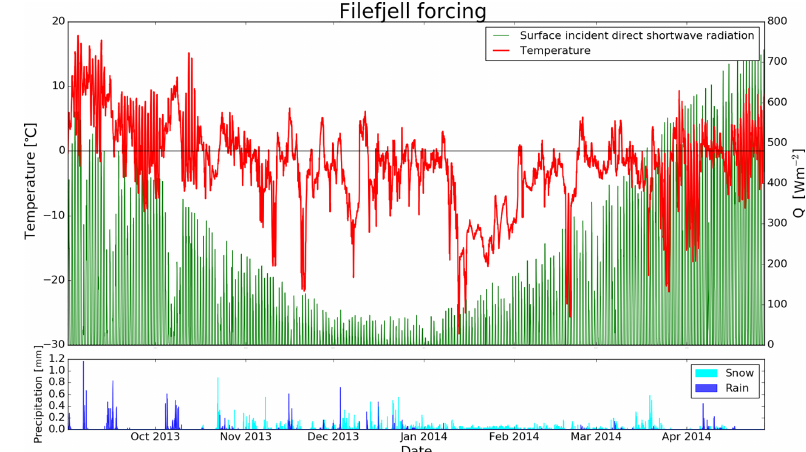
Figure 4. Forcing data from an automatic weather station located at Filefjell, Norway, for the period 1 September 2013 to 31 May